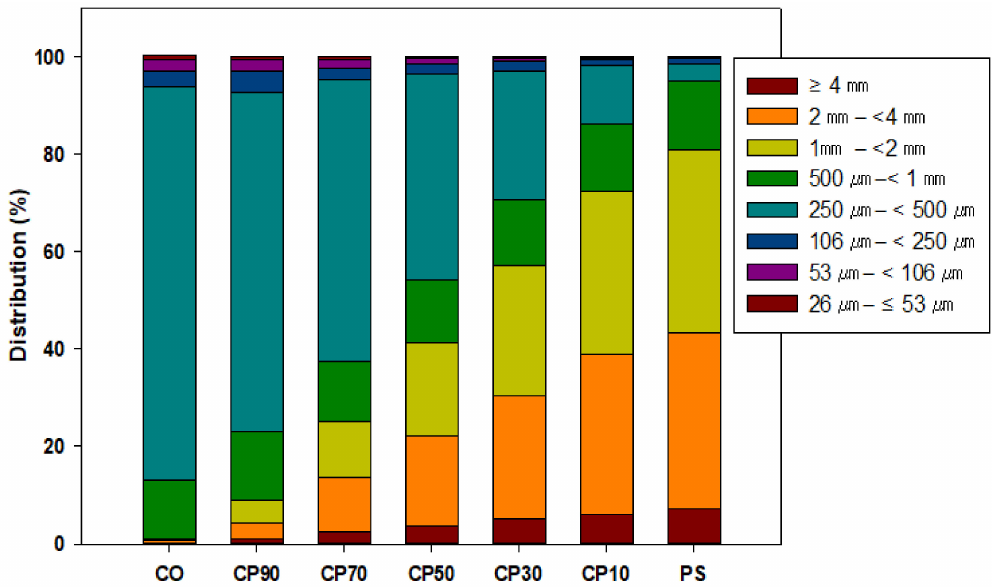
Figure 1. Particle size distribution of